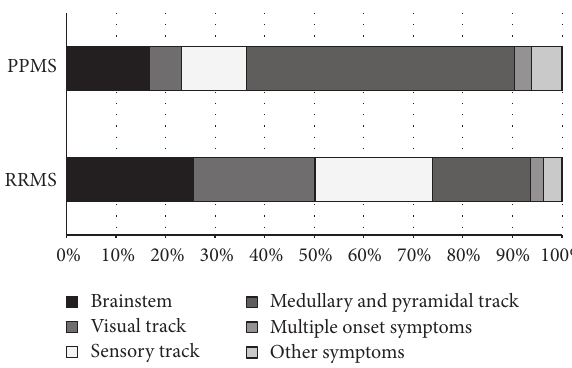
Figure 3: Distribution of onset symptoms in RRMS and PPMS groups diagnosed from 1981 to